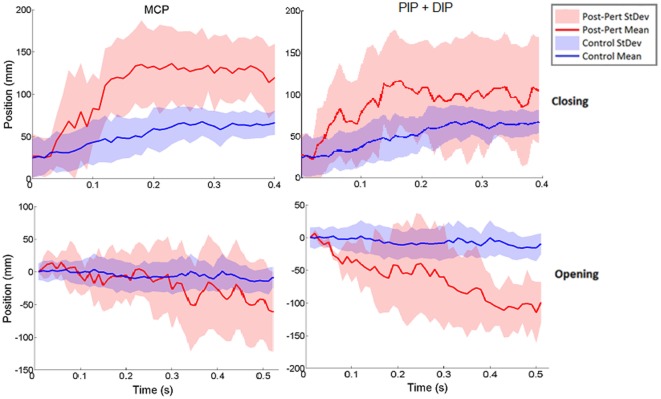
Norm of 3D thumb tip displacement vector following metacarpophalangeal (MCP) (left column) or IP (right column) joint-locked perturbation during closing (top) or opening (bottom). Movement is shown for the period of time from initiation of perturbation to end of movement phase for the unperturbed trials. Mean perturbed (red line) and unperturbed (blue line) trajectories are shown with associated SDs (shaded regions). Y-axis zeroed to the angle of perturbation such that negative angles are in closing and positive angles are in opening directions.